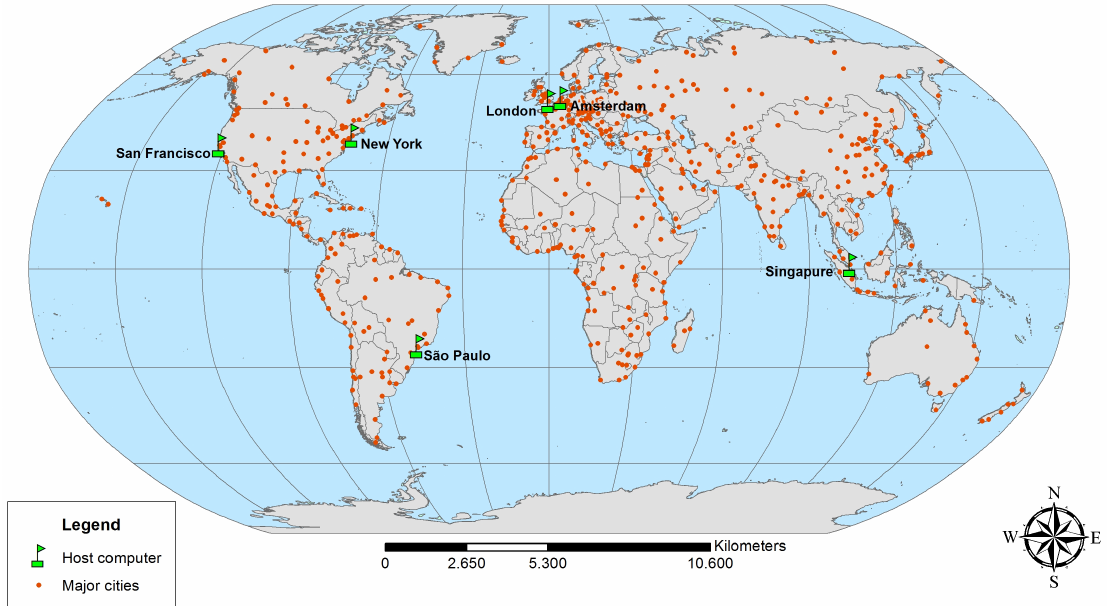
Figure 7. Hosts distribution—extracted from